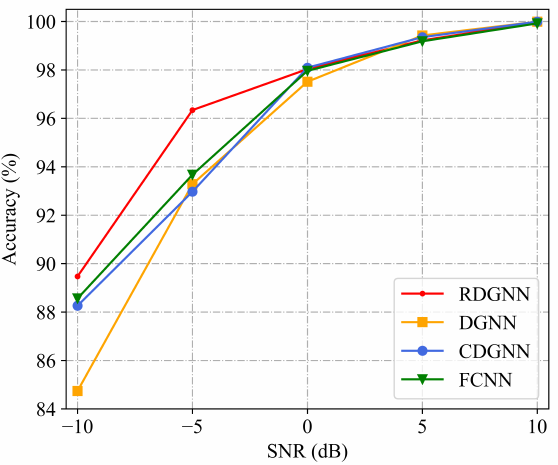
Figure 3. Comparison of recognition accuracy of different neural network structures when the maximum frequency offset is 50